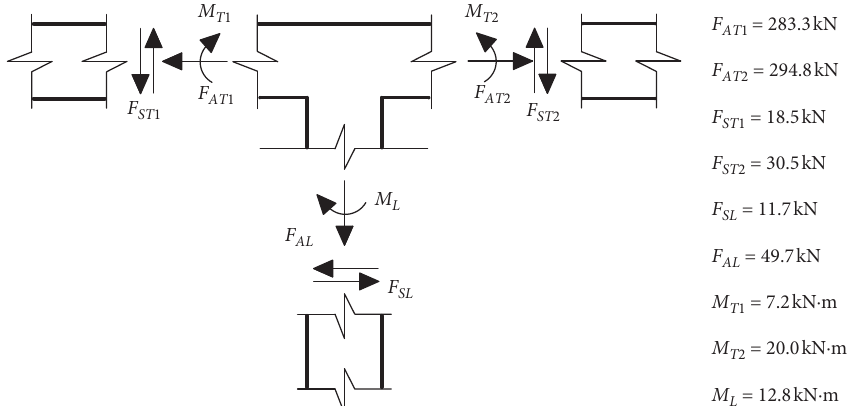
Figure 22: Force diagram of T-shaped connection.